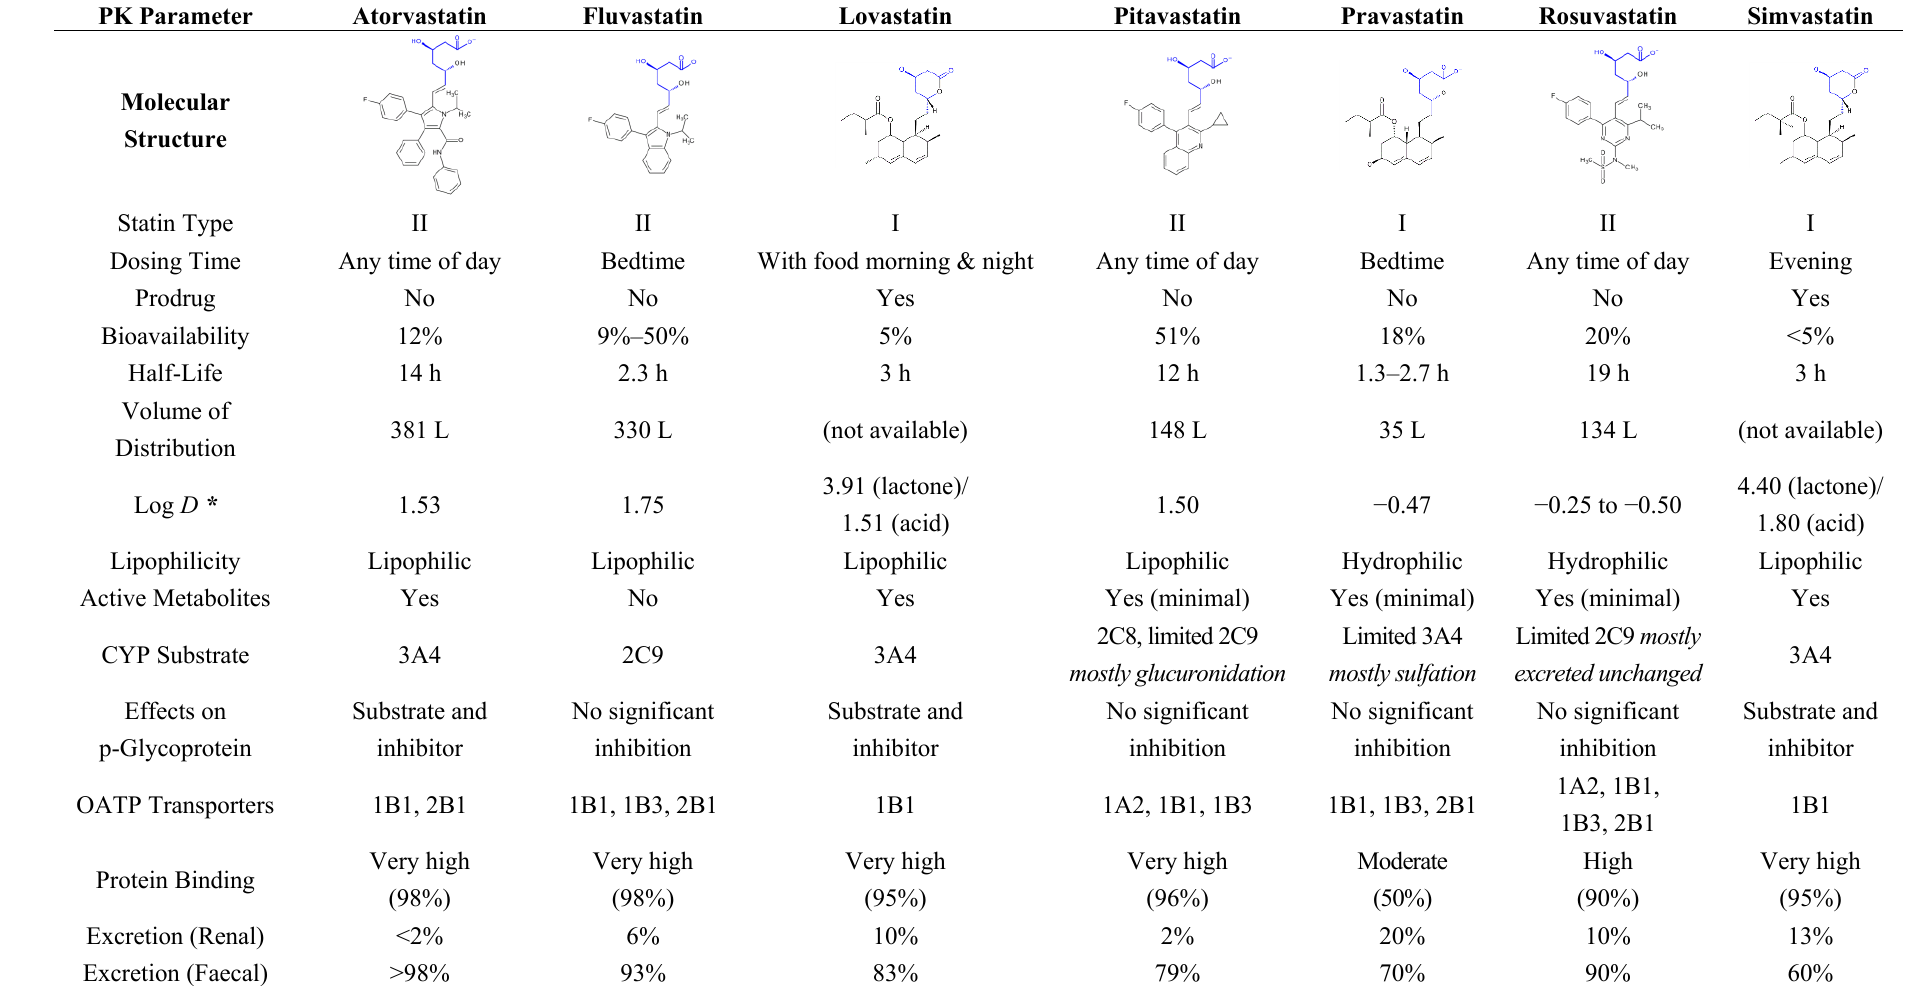
Table 1. Pharmacokinetic (PK) characteristics of commonly prescribed statins, data summarised from [5,11,13–23]. Blue-coloured moiety in chemical structures indicates the pharmacophore. * Logarithms of octanol–water distribution coefficients (log D ) are presented at pH 7.0 for rosuvastatin and pH 7.4 for all other